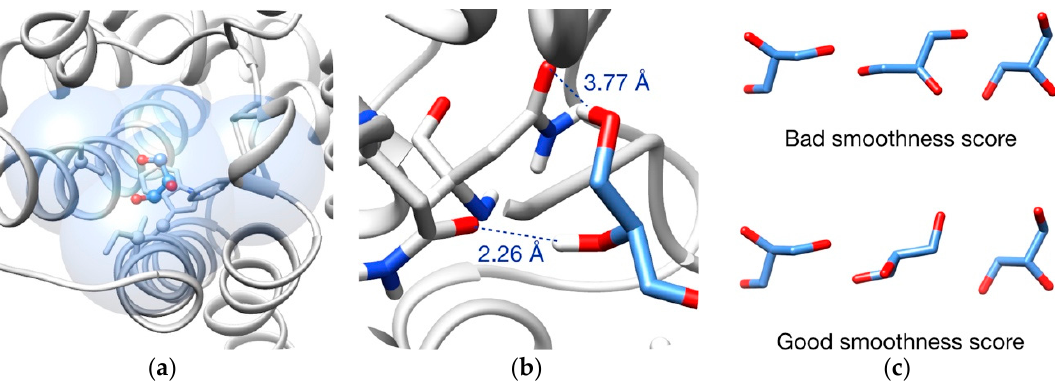
Figure 10. Pathway evaluation: ( a ) Example of clashes evaluation. Blue volume indicates the evaluation zone, which is formed by all atoms in a radius of 5 Å from every ligand atoms and carbons beta of the rotamers (highlighted in ball and sticks); ( b ) Example of Vina scoring. Only intermolecular interactions are taken into account. In dash lines, two interactions between ligand (blue sticks) and surrounding residues (gray sticks); ( c ) Example of smoothness evaluation. A bad scoring (ligand is flipped in the second frame) is shown at the top and a good scoring is shown at the bottom.